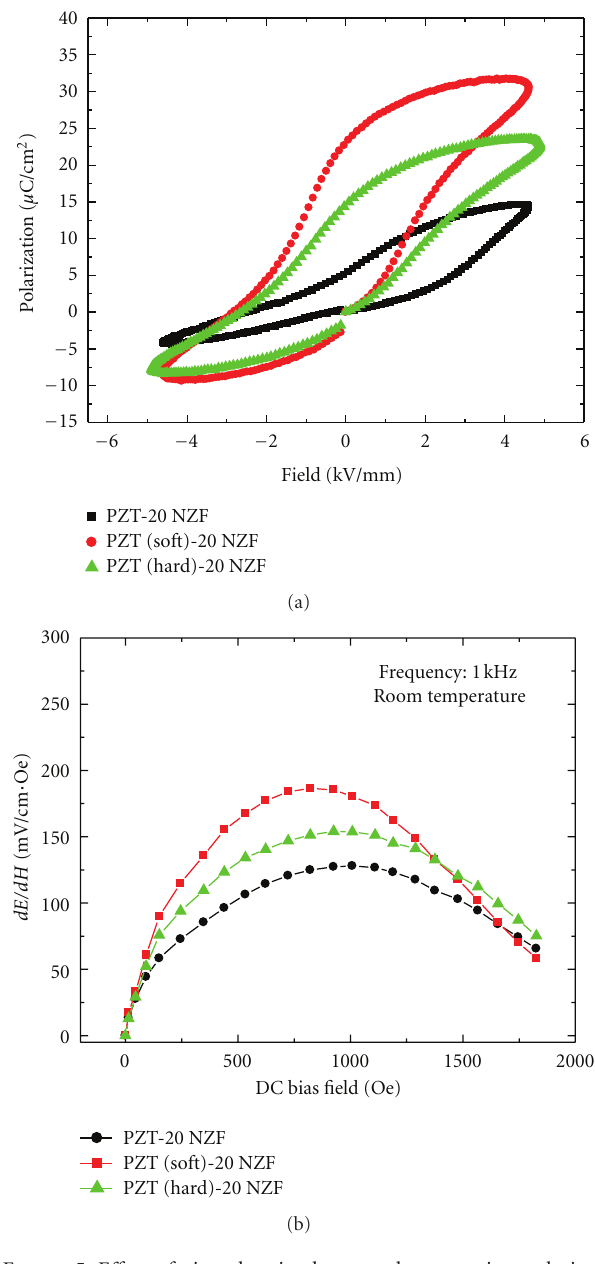
Figure 5: E ff ect of piezoelectric phase on the saturation polariza- tion and magnetoelectric coe ffi cient of ME